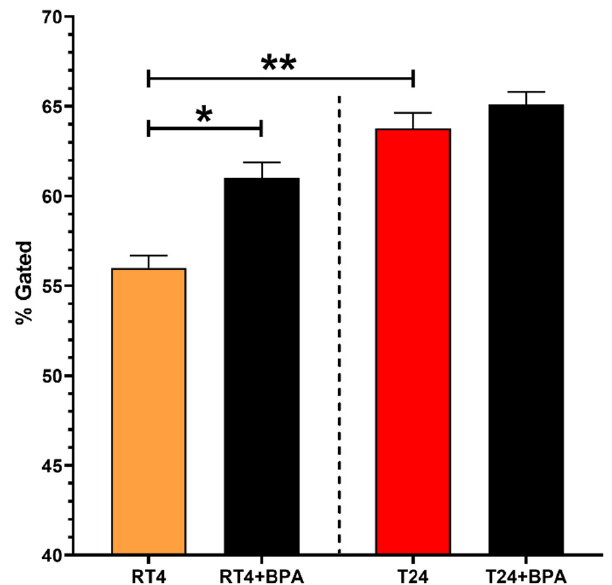
Figure 7. RT4 non-invasive bladder cancer cells chronically exposed to BPA’s physiological concen- trations exhibit an increased α -SMA expression. The expression of α -smooth muscle actin ( α -SMA) by RT4 non-invasive and T24 invasive bladder cancer cells was measured by flow cytometry with or without chronic exposure to physiological concentrations of BPA. Data are presented as the mean ± SEM (n = 6, N = 3). * p < 0.05, ** p < 0.01 by Kruskal–Wallis